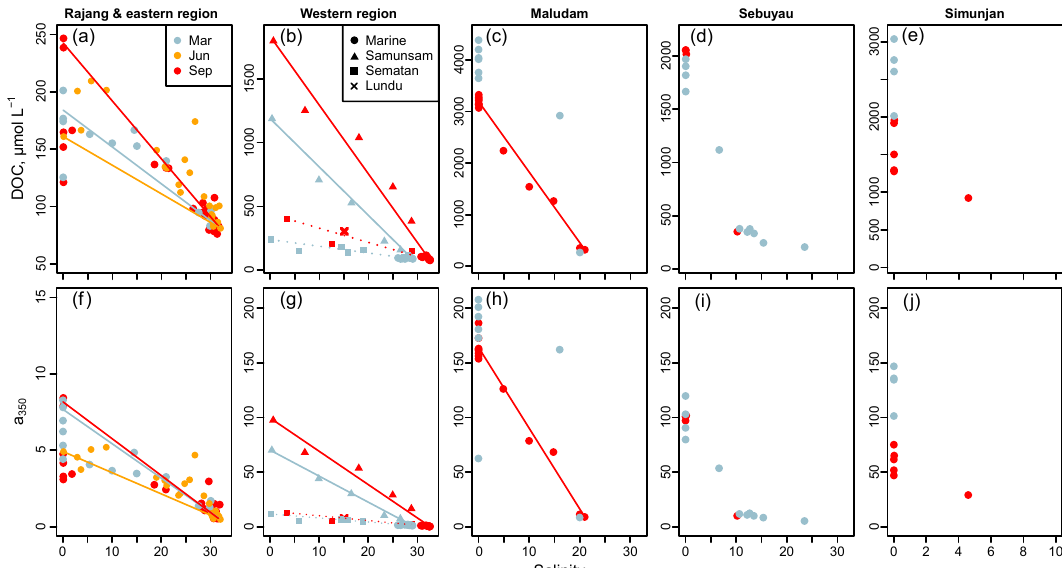
Figure 2. Changes in (a–e) dissolved organic carbon concentration and (f–j) a 350 from rivers to coastal seawater. Coloured lines show conservative mixing models for the data from the corresponding season. In (b, g) , solid versus dashed lines distinguish the mixing models for the Sematan and Samunsam rivers in the western region. Data are separated by sampling region in columns, indicated by the column titles. Colours of plotting symbols are used to distinguish sampling seasons in all panels as per the legend in panel (a)